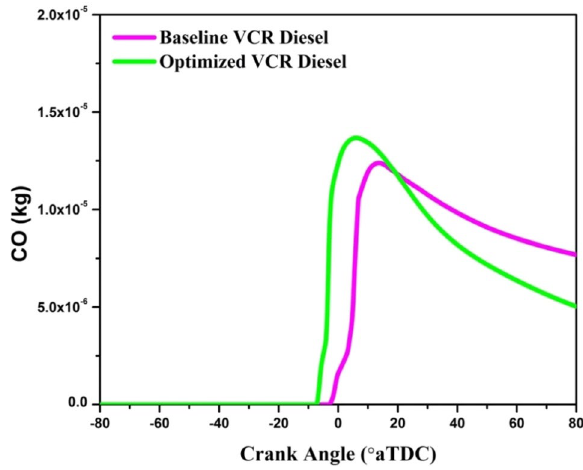
Fig. 11 Comparison of CO versus Crank Angle for baseline and optimized (VCR diesel)